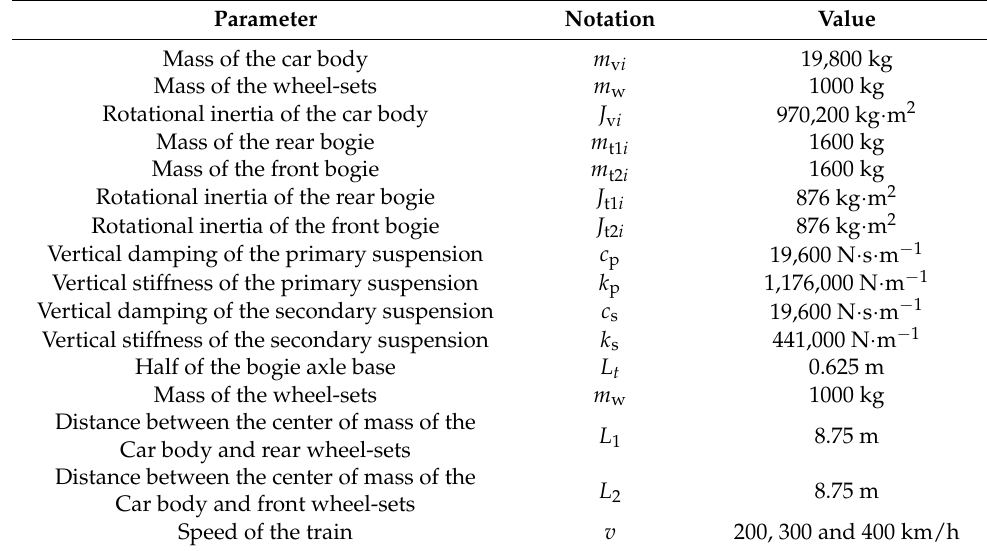
Table 1. The Parameters of the Vehicle Submodel.